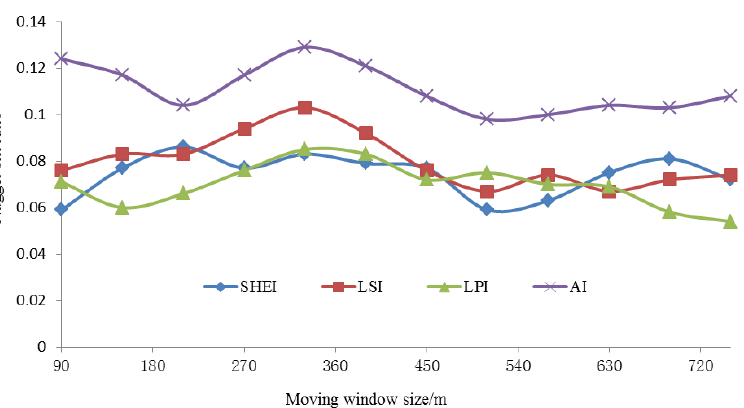
Figure 2. Changes in the nugget–sill ratios of landscape metrics with different moving window sizes. SHEI: Shannon evenness index; LSI: landscape shape index; LPI: largest patch index; AI: aggregation index.